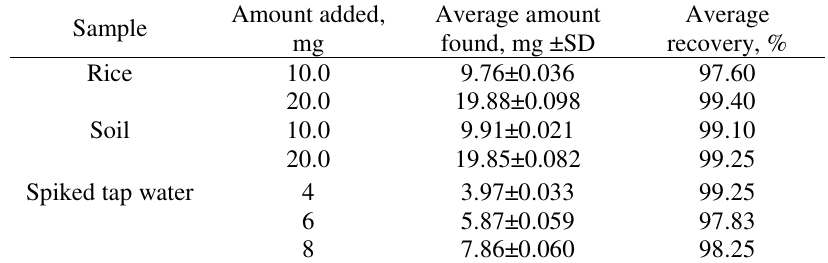
Table 6. Recoveries of fluchloralin added to grains, soils and spiked tap water samples; pulse amplitude: 50 mV, Drop time: